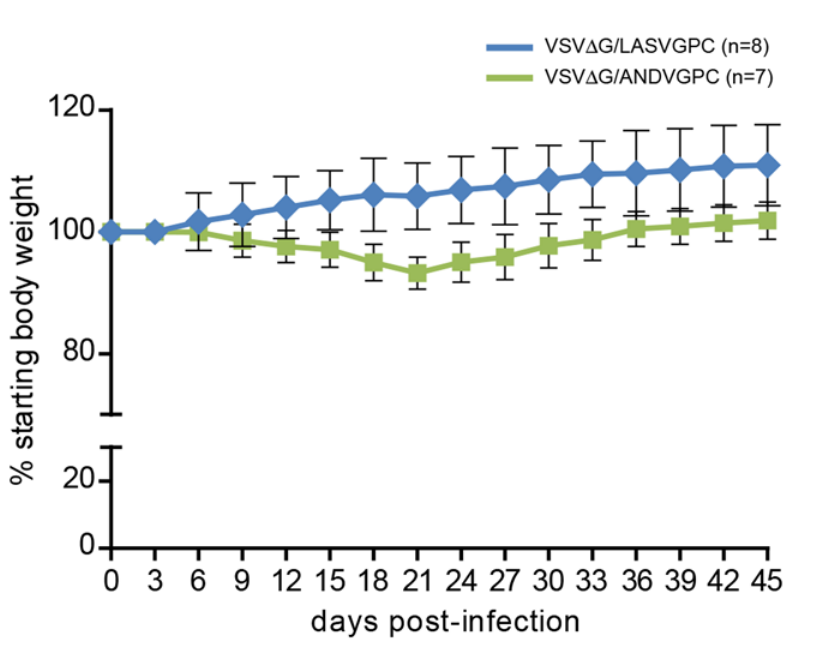
Fig 4. VSV Δ G/LASVGPC protects strain 13 guinea pigs from infection following challenge with a highly divergent Nigerian Lassa virus isolate. Adult, inbred strain 13 guinea pigs were immunized with 1 x10 6 pfu of VSV Δ G/LASVGPC (n = 8) or VSV Δ G/ANDVGPC (n = 7) and challenged 28 days later with Lassa virus strain Pinneo. Animals were monitored for disease progression including weight loss for up to 45 days.